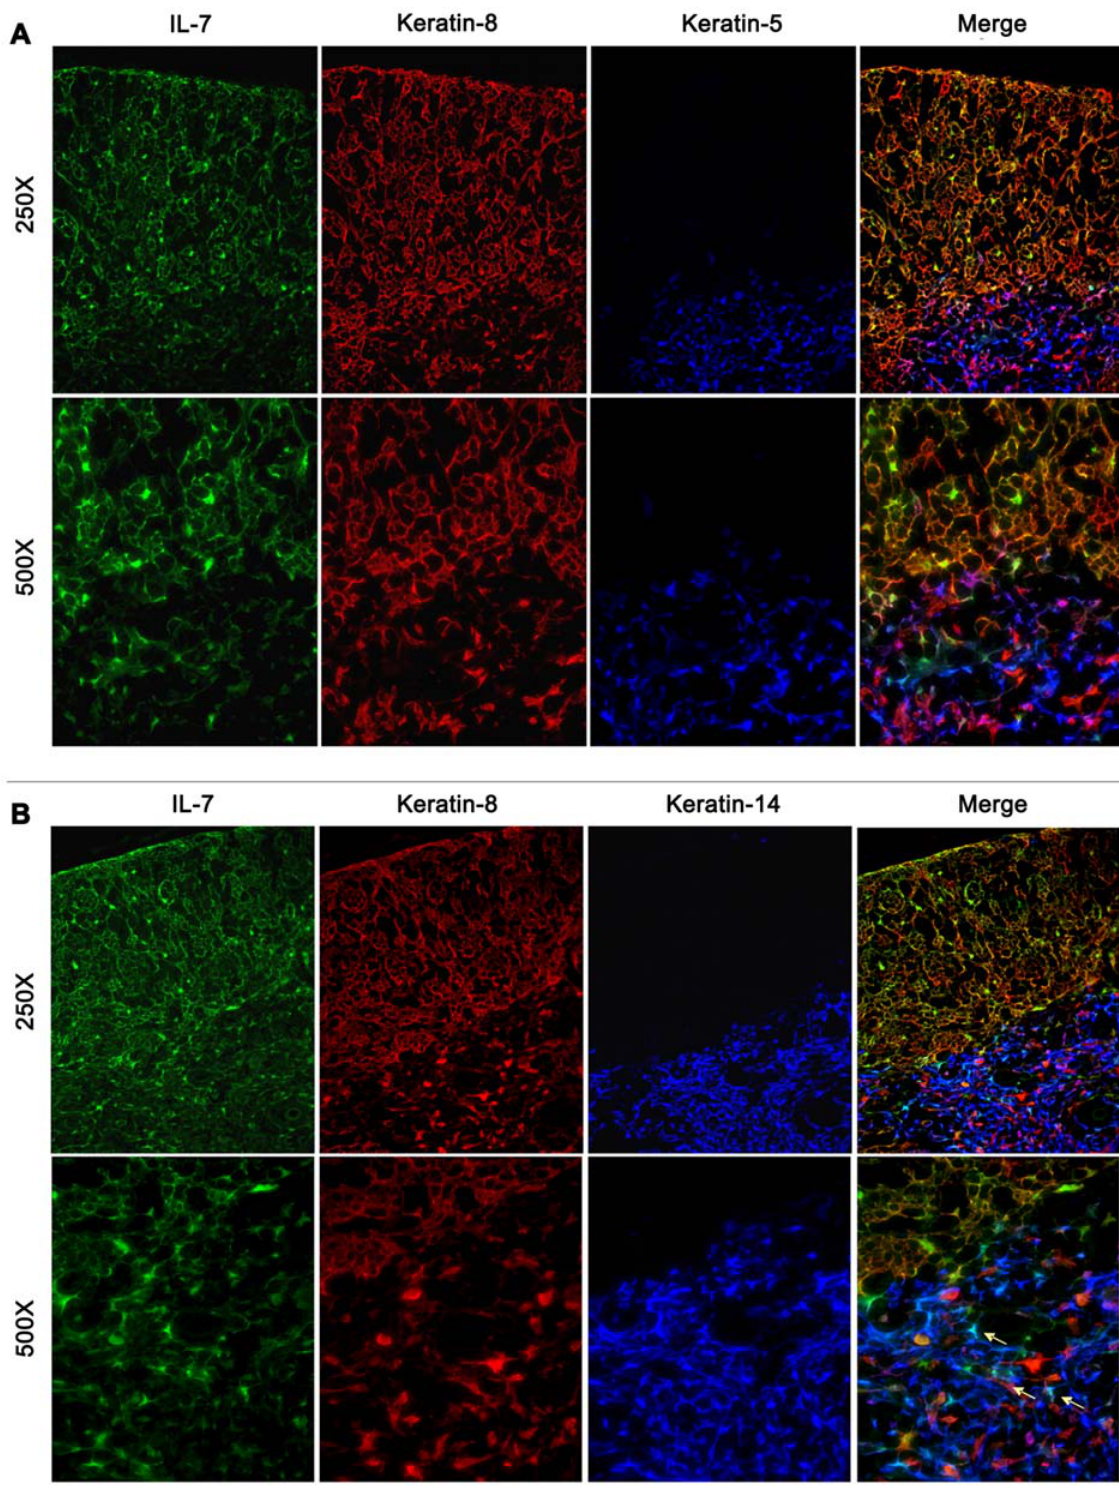
Figure 4. Cortical and medullary cell expression of IL-7 in thymic epithelial cells is confirmed by staining with different anti-keratin antibodies. A. ECFP (counterstained green) extensively co-localized with keratin-8 (red), a prominent cortical cell marker. To a less extent, co- localization is also present between ECFP (green) and keratin-5 (blue), a marker expressed to a much higher level on medullary epithelial cells than on cortical cells. Magnification 250 6 (left column) and 500 6 (right column) are shown. B. Co-localization between ECFP (green) and keratin-14 (blue), a prominent marker for medullary cells is shown in two different set of figures at different magnification (250 6 , left column and 500 6 , right column). Arrows in the merged figure highlight IL-7 producing cells positive for the keratin-14 medullary marker.